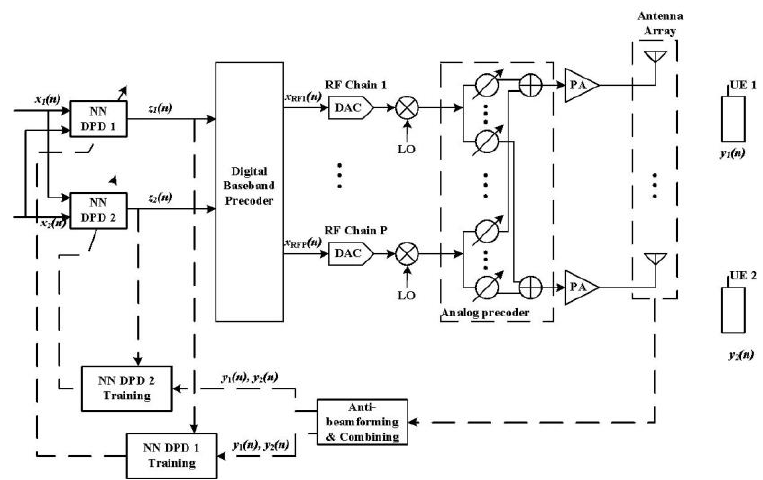
Figure 7. Architecture 2 of RVTDNN2L DPD for MU FC HBF MIMO transmitter with two NNs. Levenberg-Marquardt optimization algorithm was applied for training RVTDNN2L.